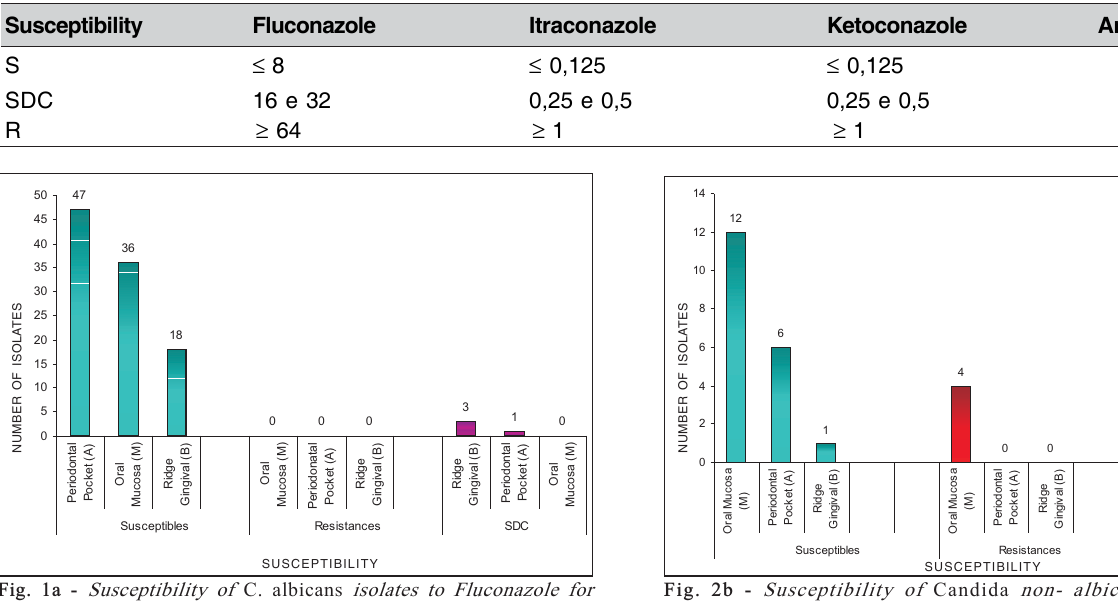
Table 2 - Criteria for Ranking for Susceptibility to Fluconazole, Itraconazole, Ketoconazole and Amphotericin B (ìg.mL ”1 ). Values of Reference of the CLSI M27-A2 (2002) 30 .